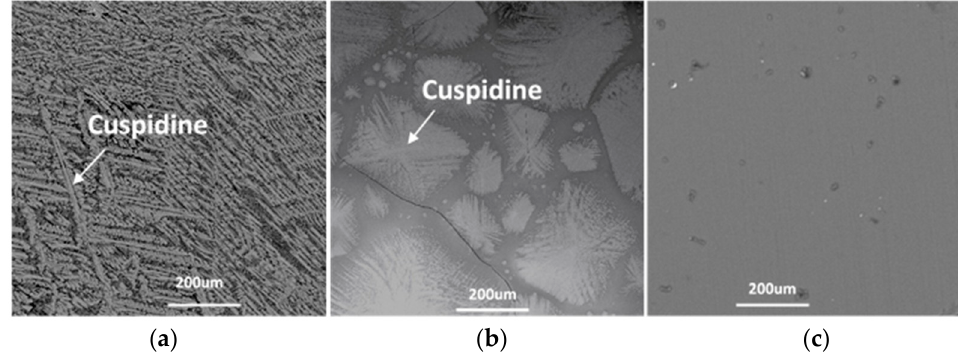
Figure 7. SEM micrographs of the CaO–SiO 2 –CaF 2 -based mold fluxes after confocal scanning laser microscopy (CSLM) measurements at different cooling rates: ( a ) 100 °C·min − 1 , ( b ) 150 °C·min − 1 , and ( c ) 200 °C·min − 1 .